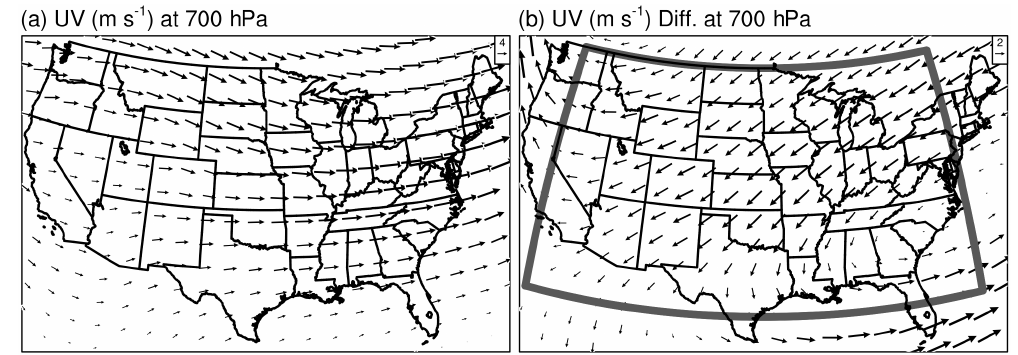
Figure 6. (a) Horizontal winds at 700hPa averaged over the winter months of NDJFM of 1986–2006, and (b) the corresponding differences between the PNA + and PNA − months. data sets are from the assimilated GEOS-4 meteorological fields. Also shown in (b) is the domain of (75–120 ◦ W, 28–49 ◦ N) for which transboundary mass fluxes of PM 2 . 5 are calculated. See Fig. 2c for the definitions of PNA + and PNA − months.